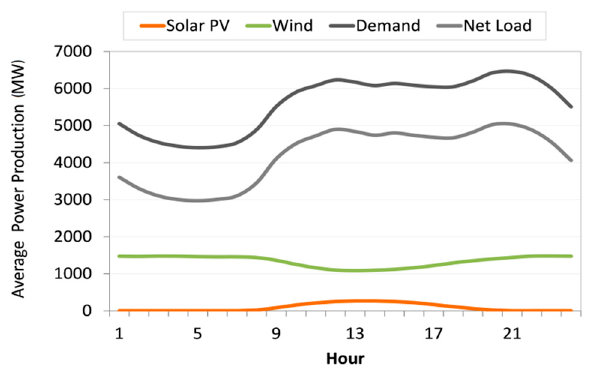
Figure 3. National aggregated daily average power production (green—wind; orange—solar PV), demand (black), and net load (gray) during 2015.